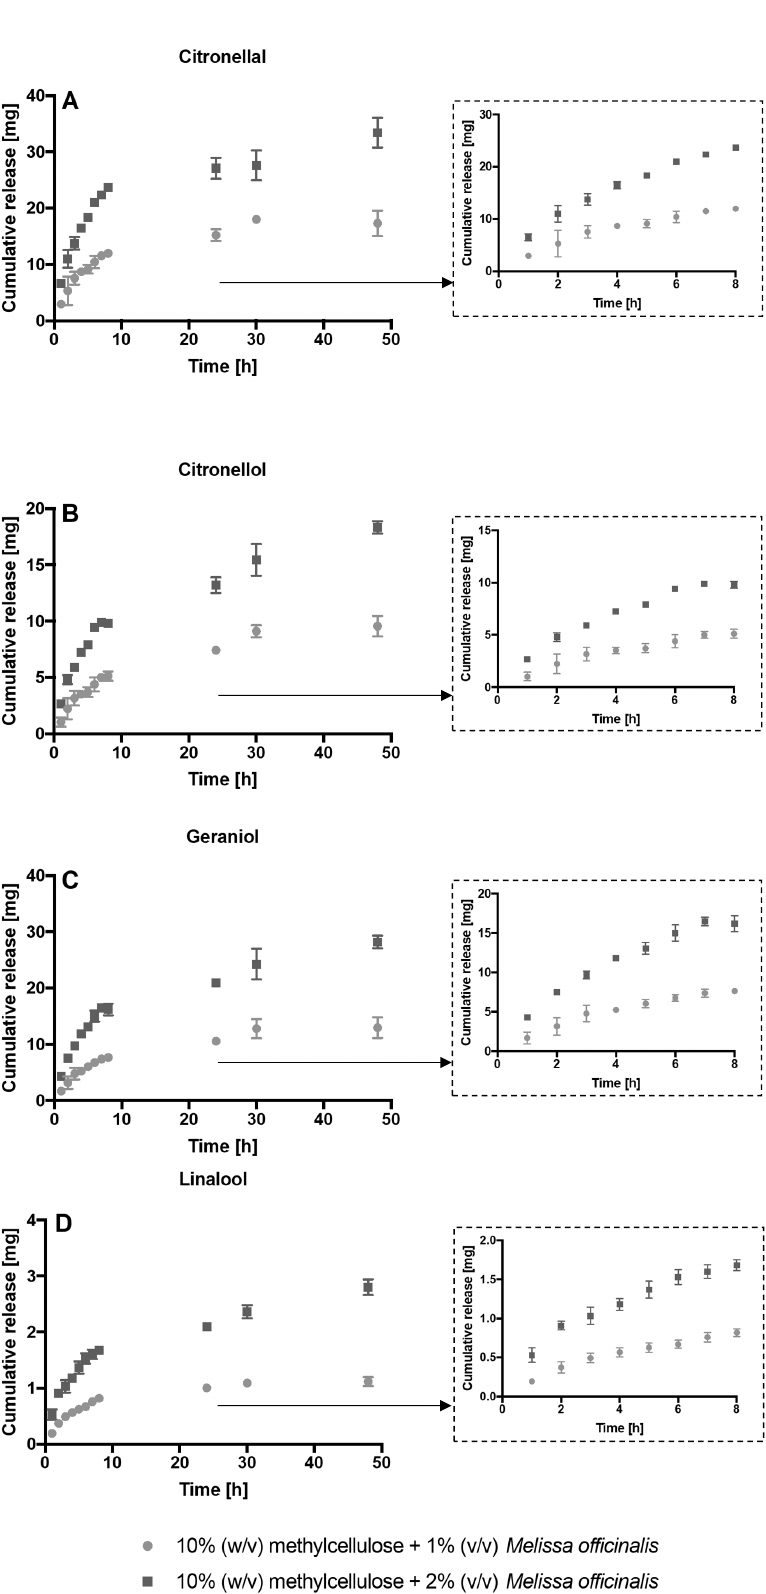
Figure 4. Retention assay after 1 h of exposure of C. albicans to 10% ( w / v ) methylcellulose hydrogels with or without 1 or 2% ( v / v ) Melissa officinalis. 3.4. Disk Diffusion Method 0.00E+005.00E+031.00E+041.50E+042.00E+042.50E+043.00E+043.50E+044.00E+044.50E+04